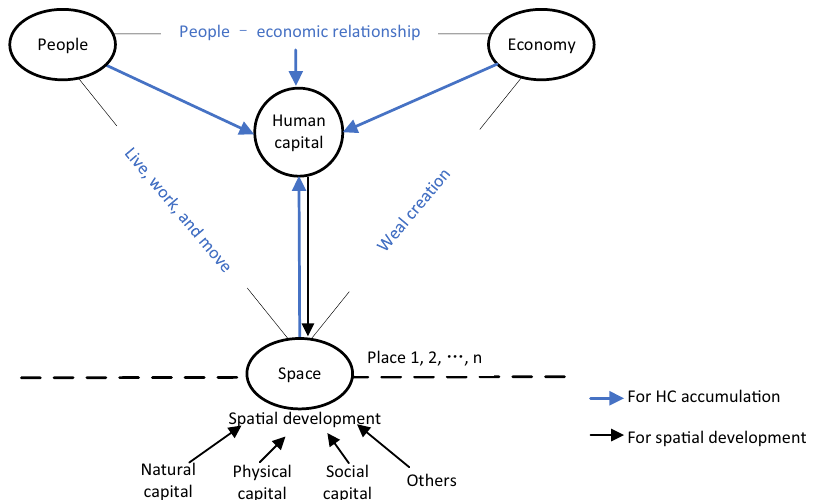
Fig. 1 Human capital and space in societal development. People, the economy, and space are the three main dimensions in societal development. The fi gure depicts the interactions and relations among them. Human capital (HC) captures people ’ s and economic relationships, whose accumulation depends on favourable relations and spatial settings such as natural resources, infrastructure, and facilities. Space is developed by human, natural, physical, and social capital and others. However, places are intertwined and compete with each other. Therefore, HC fl ows in space with people ’ s